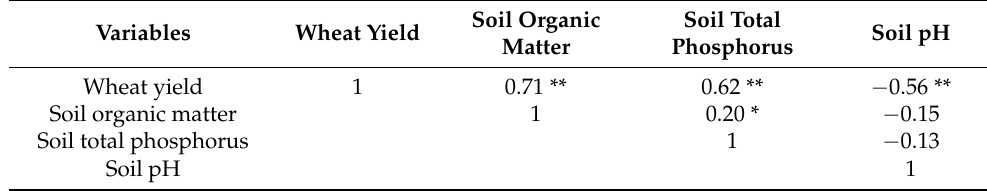
Table 2. Pearson’s correlation coefficients between wheat yield and its main impact